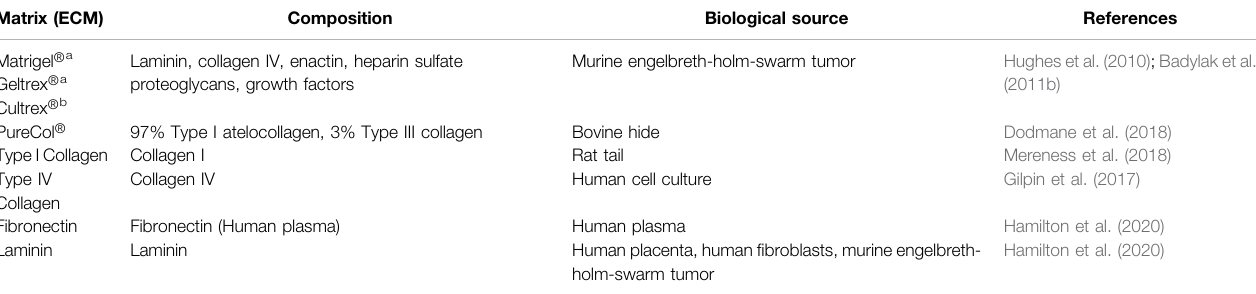
TABLE 1 | Matrices available for the culture of pulmonary basal stem